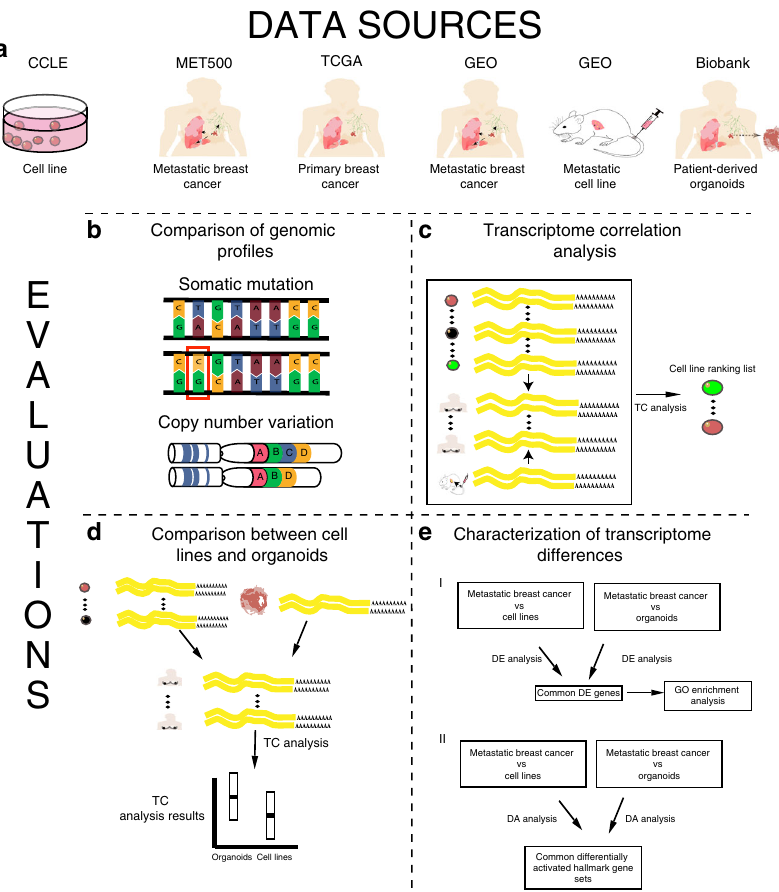
Fig. 1 Overall research design. a Data sources and sample types used in this study. b – e Evaluations performed in this study: b comparison of genomic pro fi les, c transcriptome correlation analysis, d comparison between cell lines and organoids, and e characterization of transcriptome differences. TC analysis: transcriptome correlation analysis; DE analysis: differential gene expression analysis; DA analysis: gene set differential activity